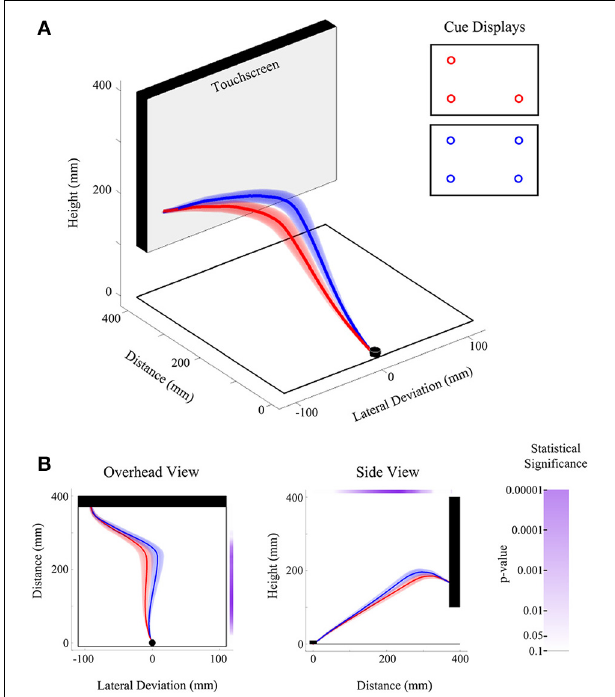
FIGURE 4 | Illustration of experiment results using FDA. (A) Three-dimensional view of the group-averaged reach trajectories for 2v1(low) (red) and 2v2 (blue) target displays. Results are shown for trials on which only the bottom left target was selected as the final target. Shaded areas around the darker trajectories represent average standard errors across subjects. (B) Data is the same as in (A) , except shown from an overhead (left) and side (right) view. Significance bars (shown in purple at right and top for the overhead and side views, respectively) provide a measure of where there are statistical differences between red and blue trajectories in the lateral dimension (at left) and height dimension (at right). The color saturation of the significance bar denotes the statistical threshold. See the significance bar at far right for interpretation of statistical significance